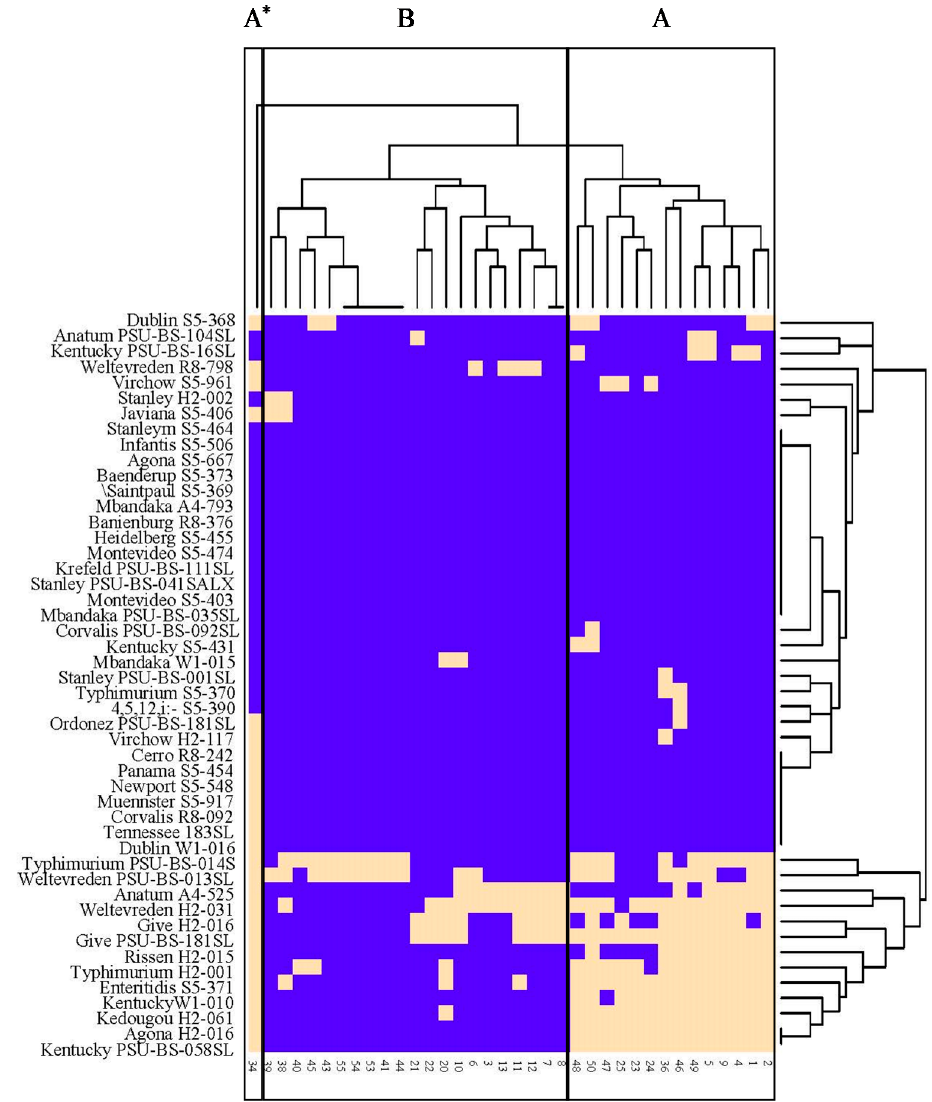
Figure 1. Heatmap representation of lysis profiles of 36 Salmonella phages tested (vertical axis) on 47 Salmonella host strains (horizontal axis) from Thailand and USA Phages were classified into three groups, including ( A ) broad, ( B ) narrow and ( A* ) special broad host range. Beige areas indicate lysis and darker areas indicate no lysis.